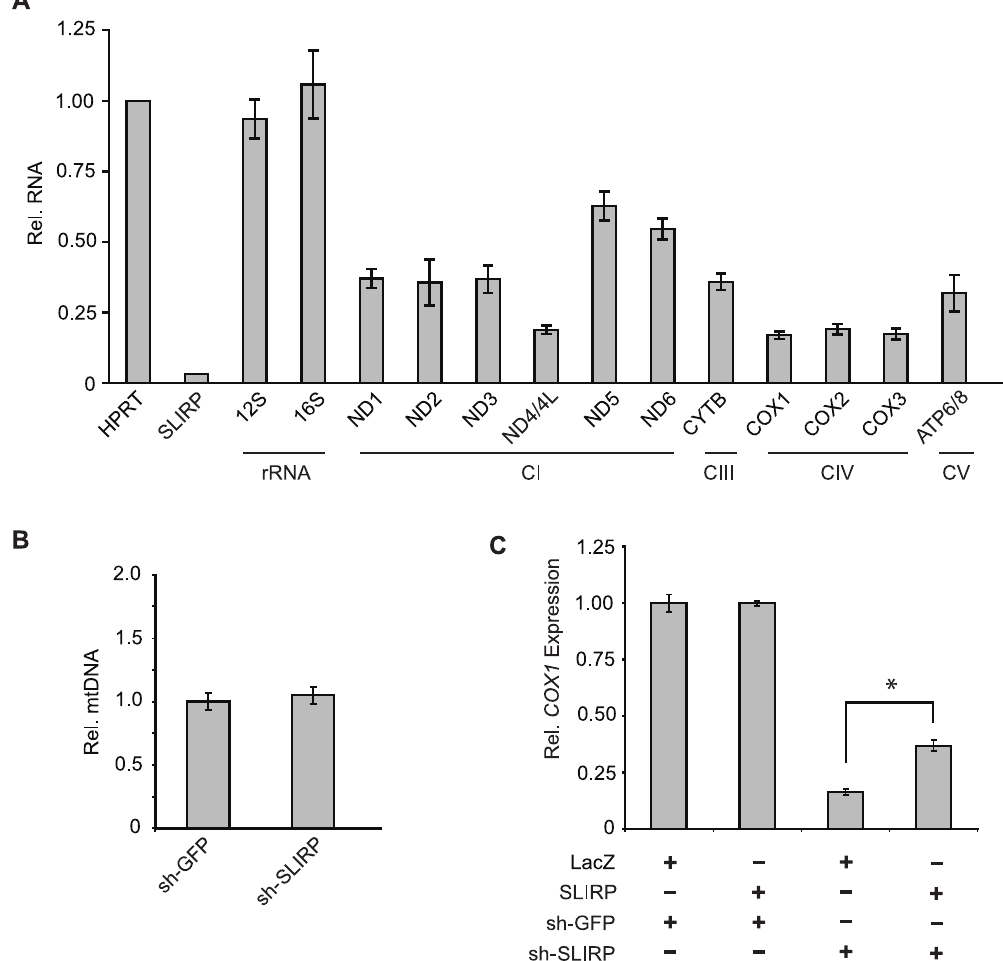
Figure 5. SLIRP maintains mitochondrial mRNA. (A) Expression levels of mitochondrial transcripts in MCH58 cells measured by qPCR 10 days post-infection with either control shRNA (shGFP) or shRNA targeting SLIRP . Values are reported as fold change over shGFP-treated cells, in each case normalized to HPRT as an endogenous control, and represent means (n=3). All values except 16S and 12S were significantly decreased compared to shGFP (P , .05, two-tailed unpaired t-test). (B) mtDNA copy-number per cell measured by qPCR using genomic DNA from the samples in (A). Values represent mean mtDNA/nuclear DNA ratio (n=3). (C) COX1 expression measured by qPCR in MCH58 cells infected with shSLIRP or shGFP. Labels LacZ and SLIRP indicate cells transfected with constructs to over-express LacZ or human SLIRP, respectively. Values reported are mean ratios over LacZ + shGFP (n=3). Error bars indicate standard deviation. *, P , .05 (two-tailed unpaired t-test).